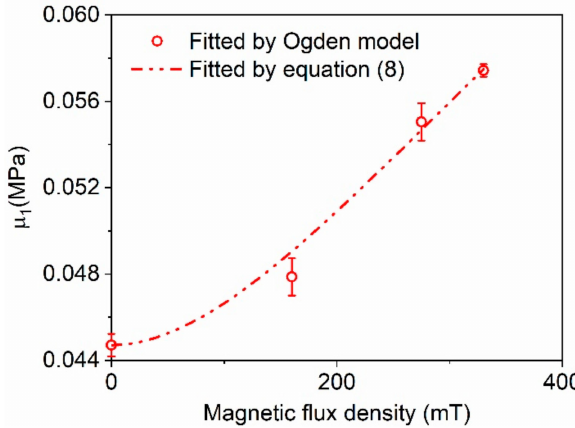
Figure 5. Comparison between the fitting values of sti ff ness parameter µ 1 and the calculation results using Equation